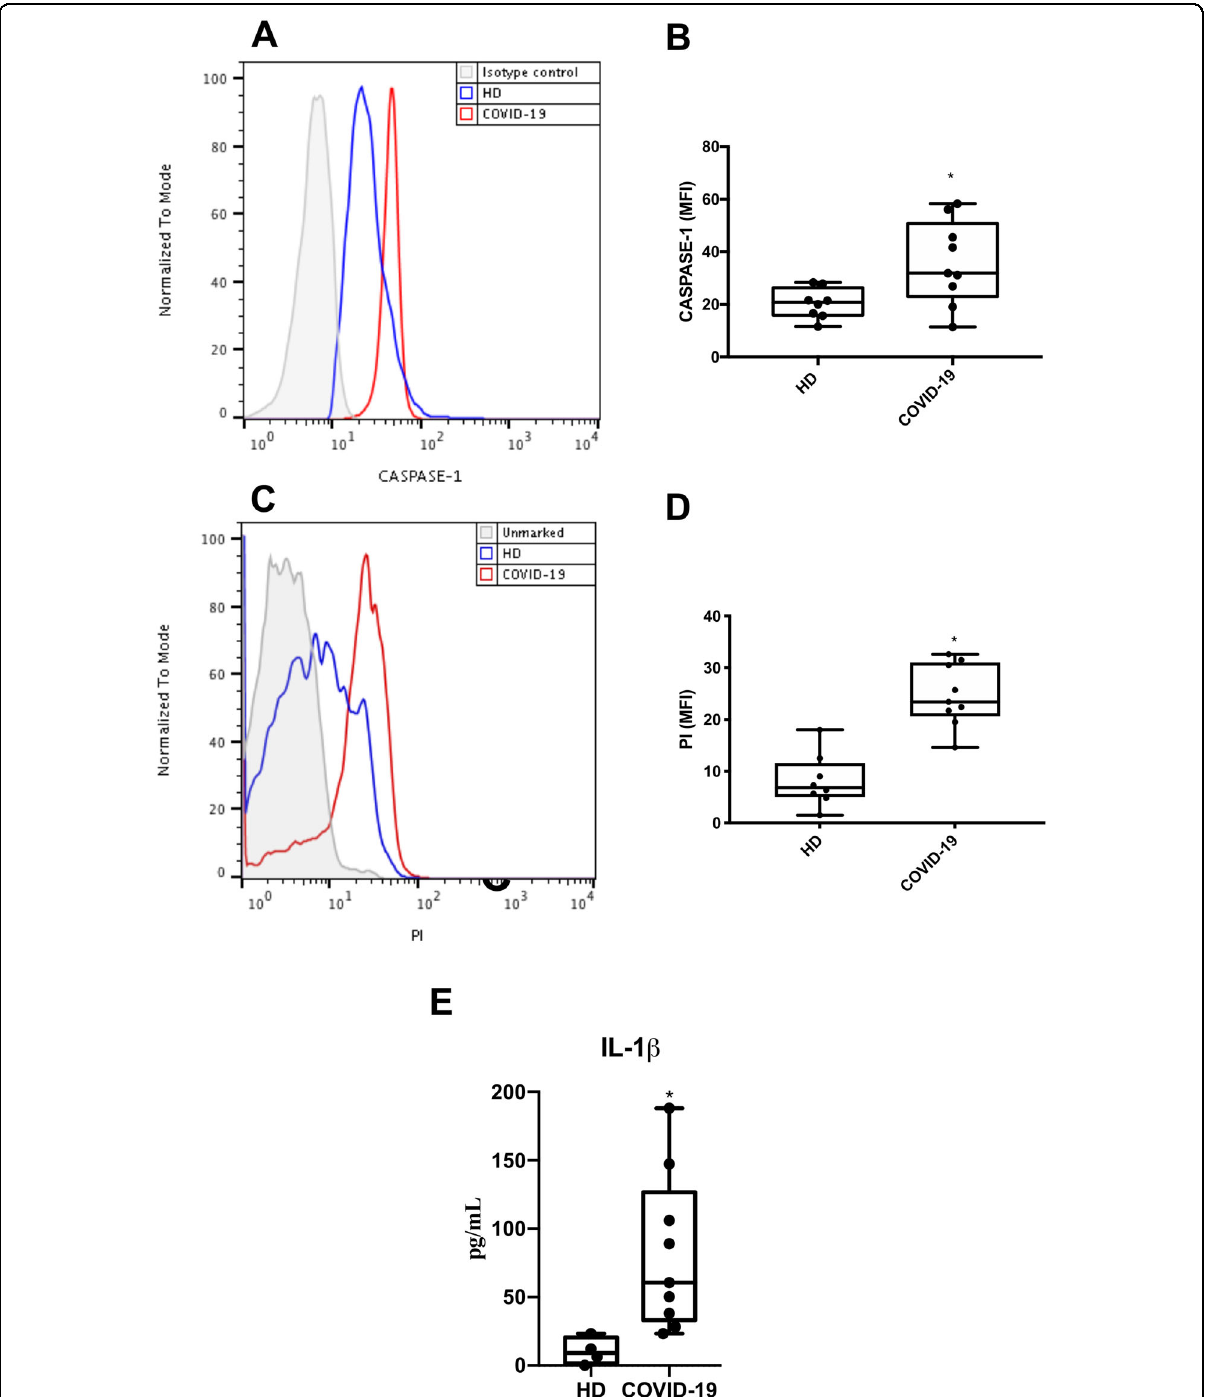
Fig. 5 Caspase 1 activation, lytic monocyte death, and increased Il-1 β lvels associate with severe COVID-19. Monocytes were isolated from blood samples of critically ill patients with COVID-19 and healthy donors. These cells were stained with FAM-YVAD-FLICA ( A , B ) or propidium iodide (PI) ( C , D ). Plasma samples were analyzed for IL-1 β levels ( E ). Western blotting, histogram and graphs data are representative of nine critically ill patients and eight healthy donors. Data are presented as the mean ± SEM * P < 0.05 versus healthy donors